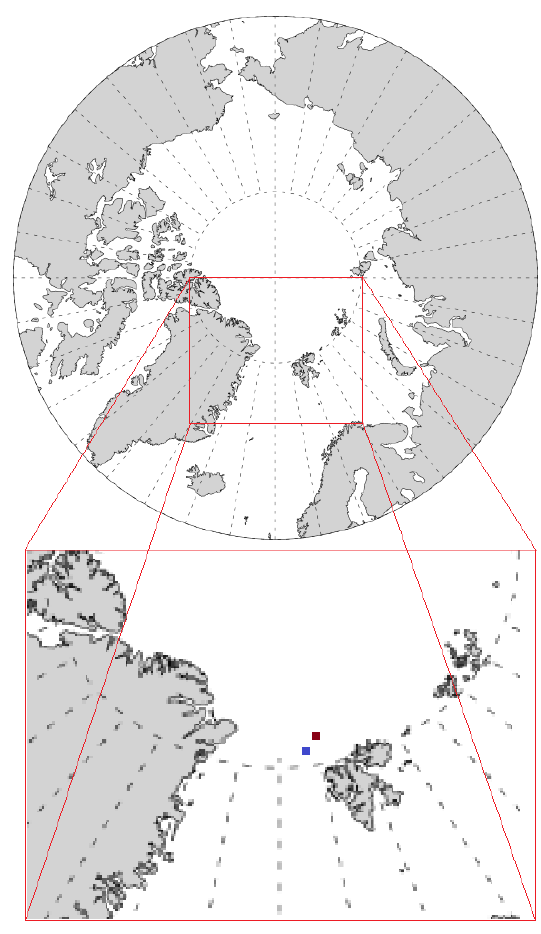
(brown) and 910C (blue), used by Knies et al. (2014) for IP 25 anal-